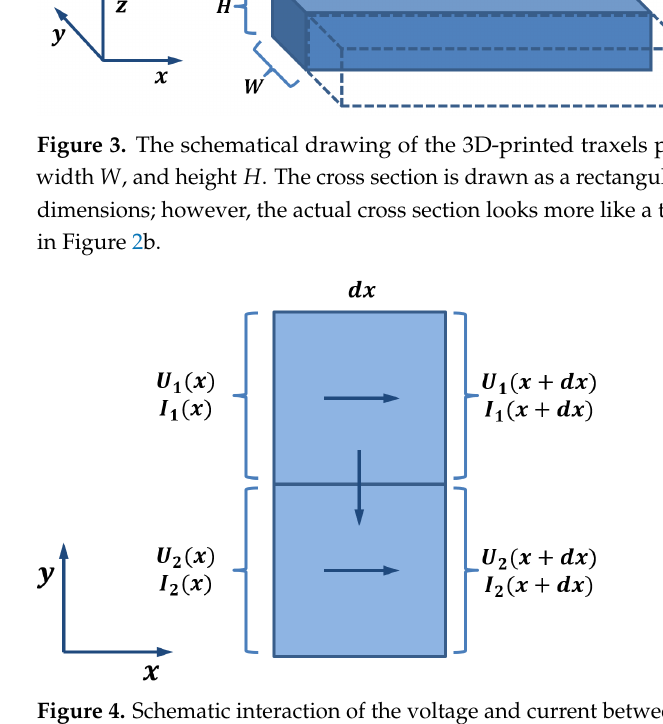
Figure 4. Schematic interaction of the voltage and current between two neighbouring traxels slices of ∆ x